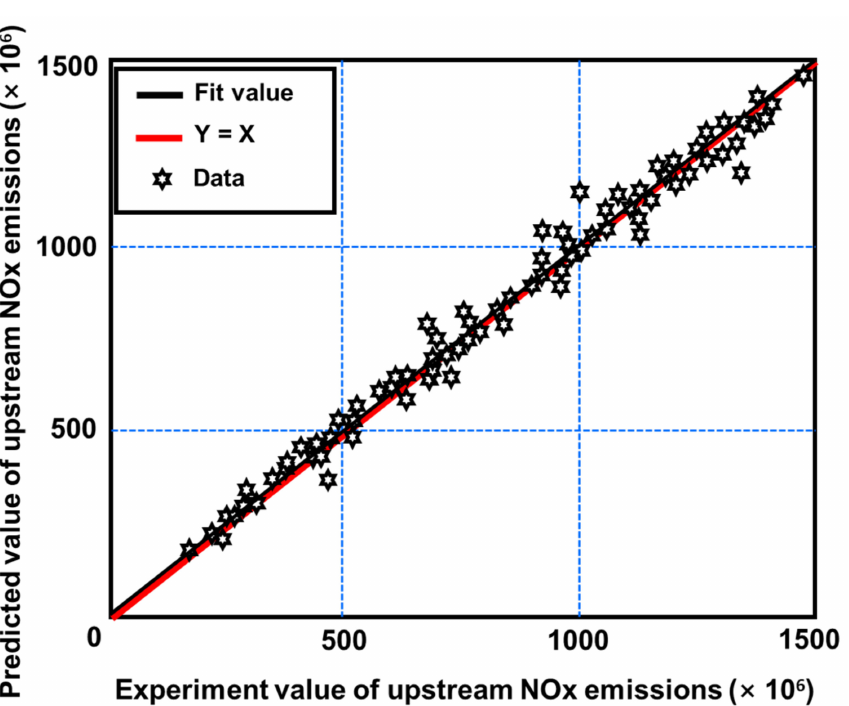
Figure 23. Quality of fit for the comparison of experimental and projected NOx emissions [92].